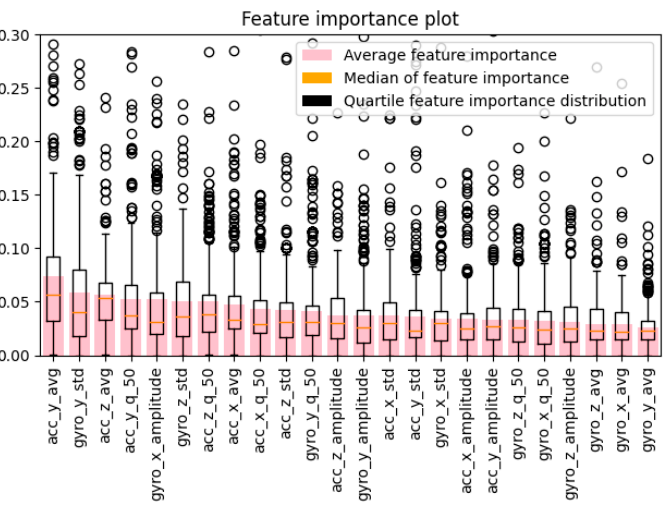
Figure 4. Feature importance of aggregated data (averages, standard deviations, medians, and amplitudes) of the x , y , and z axes of the accelerometer and gyroscope readings.